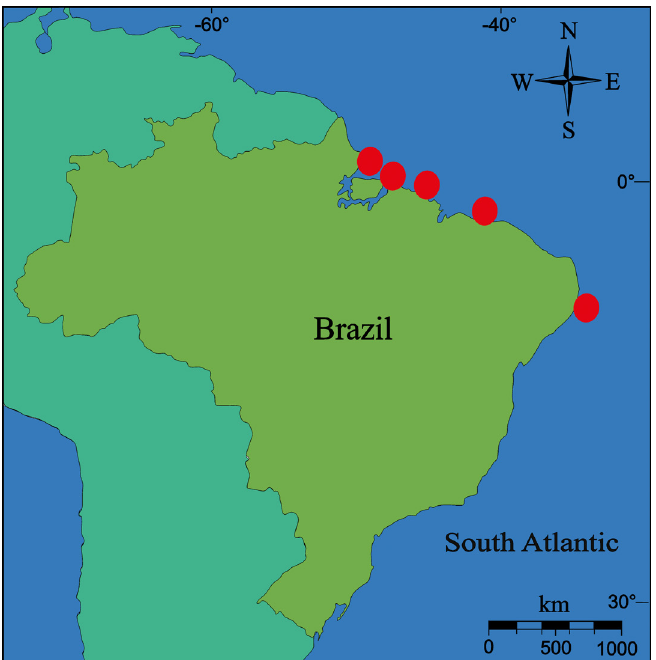
Figure 2. Distribution of Excorallana bicornis Lemos de Castro and Lima, 1971 for Brazilian